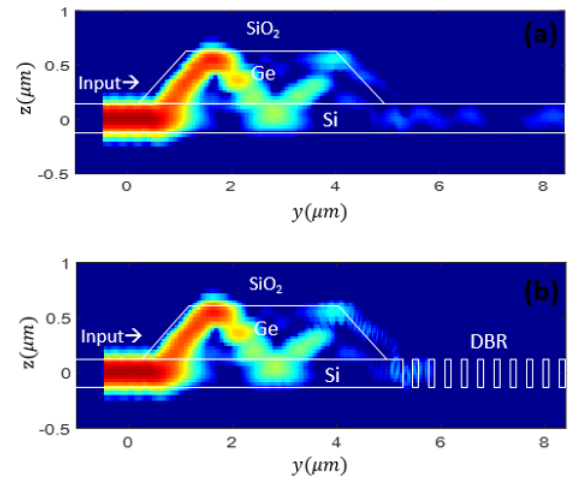
Fig. 2. Simulated electric field distribution in the Ge PD without DBR in (a) and with DBR in (b) . The use of DBR reflects the unabsorbed light back into the Ge PD for re-absorption.